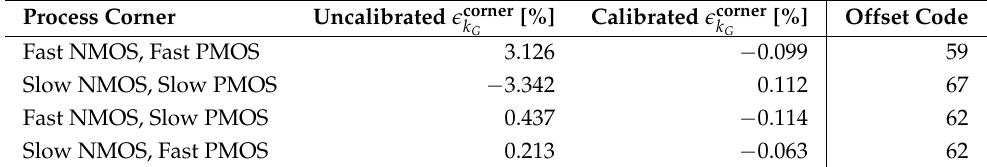
(see Equation (20)) againts process corners: before and G [%] Calibrated (cid:101) corner [%] Offset Code k G k G